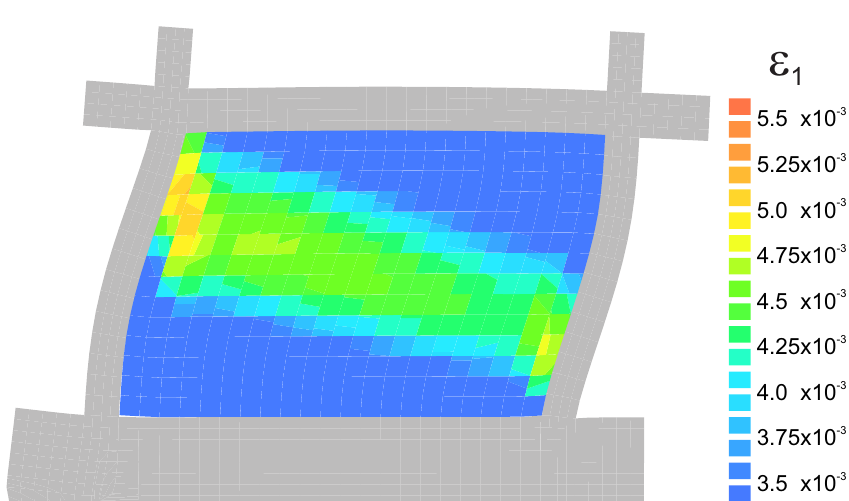
Figure 20. Failure mechanism obtained by numerical simulation as map of maximum principal plastic strain at ∆ = 10